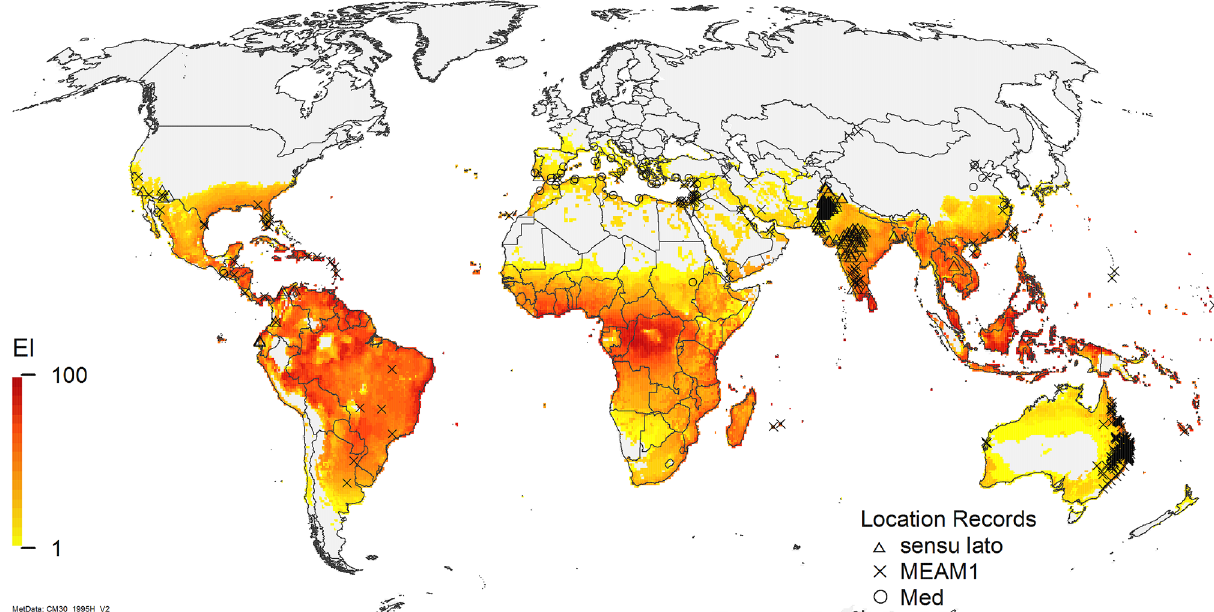
Figure 1. Modelled global potential distribution of Bemisia tabaci s.l. under a composite scenario of natural rainfall and irrigation (Kriticos et al. 64 ). Outlying location records in northern China are thought to represent populations that overwinter in glasshouses in areas that are otherwise unsuitably cold for population persistence of B. tabaci MEAM1. The climate data is the CM30 1995H V2 dataset 65 . Map produced using ArcMap 10.6 (ESRI, Redlands, Ca.,